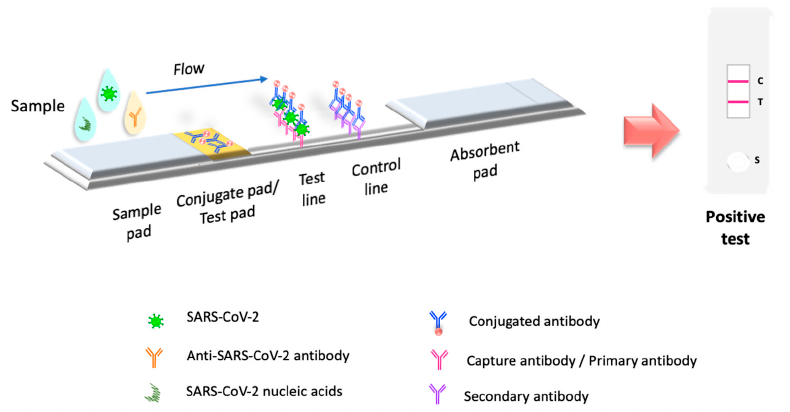
Figure 1. Principle of LFIA test. LFIA test detects the target molecule on an absorbent membrane with antibodies aligned to form the test and control lines. The sample is placed on a sample pad, then migrates to the conjugate pad, which contains the immobilized conjugate, usually made of nanoparticles (colloidal gold, colored or fluorescent latex, colored cellulose) conjugated to antibodies or antigens. The sample interacts with the conjugate, and both migrate to the next section of the strip, where the biological components of the assay (proteins/antibodies/antigens) are immobilized. In this section, the analyte and conjugate are captured. Excess reagent passes through the capture lines and accumulates on the absorbent pad. The results are interpreted on the nitrocellulose membrane as the presence or absence of the test and control lines.